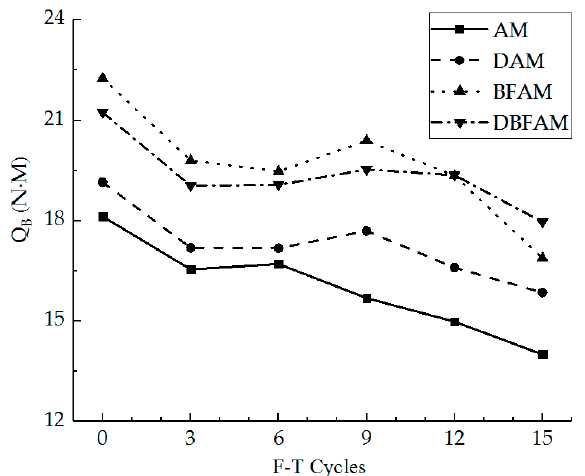
Figure 11. Deformation energy density under F–T cycles.